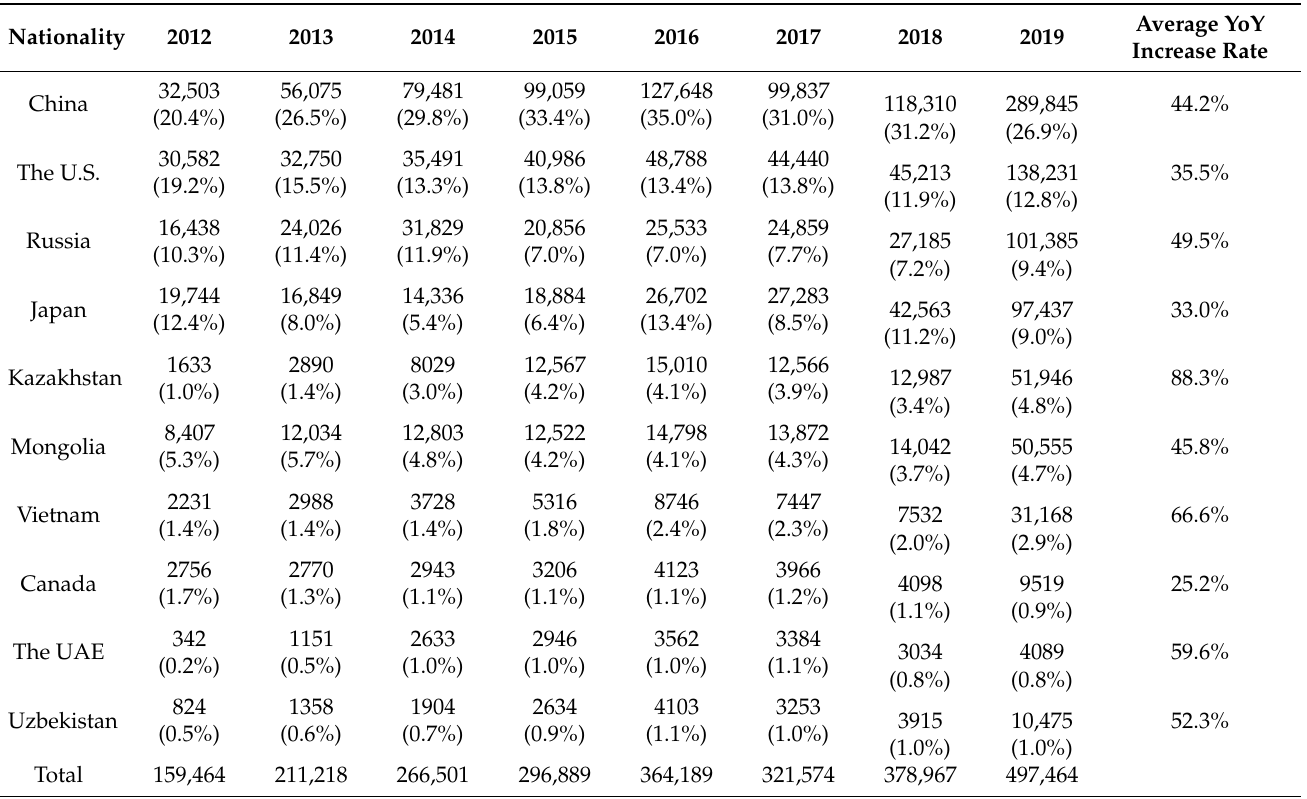
Table 4. Total number of foreign patients by